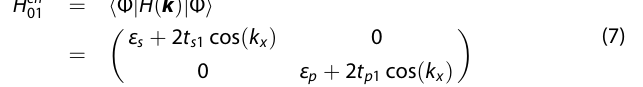
ð k Þ ; ϕ ð k Þj i . Two edge spectra are obtained in x x 1 2